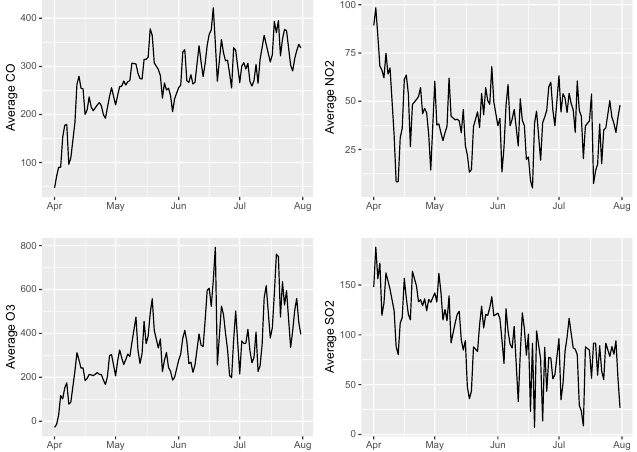
Figure 11. Examples of time series of NO 2 , SO 2 , O 3 in mg/m 3 and CO in ppb that were recorded by one of the sensors in